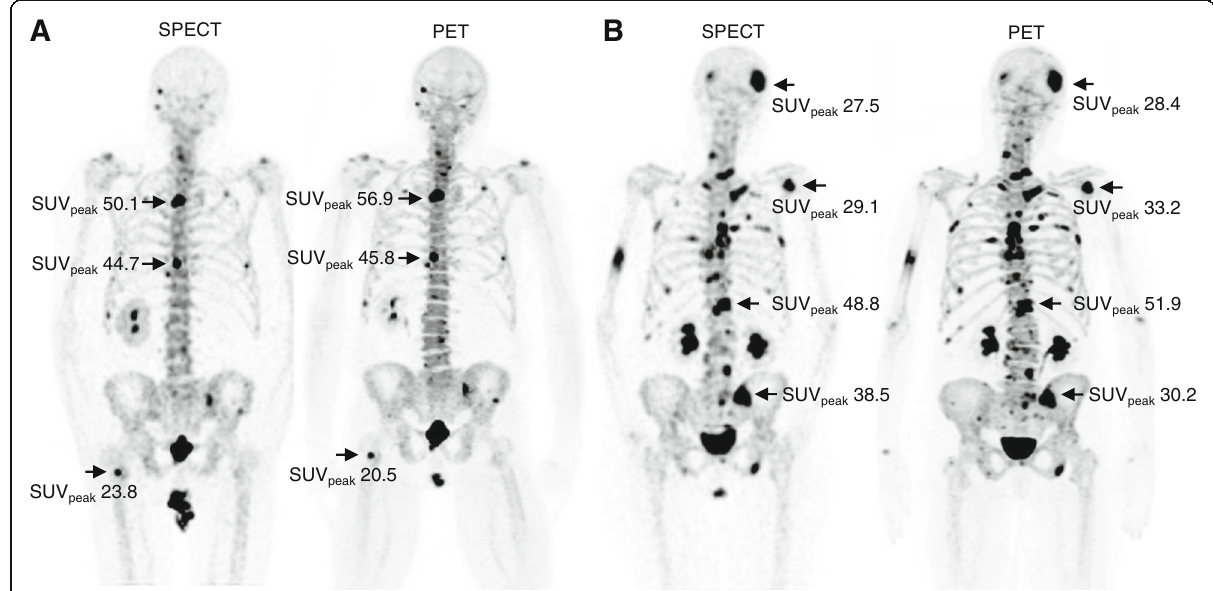
Fig. 1 Maximum intensity projections of 99m Tc-HDP SPECT and 18 F-NaF PET scans acquired ( a ) from the same 66-year-old prostate cancer patient and ( b ) from the same 75-year-old breast cancer patient. SUVs peak are shown for most active lesions. The SPECT scan of the prostate cancer patient was acquired 2 days before the corresponding PET scan and the SPECT scan of the breast cancer patient 5 days after the corresponding PET